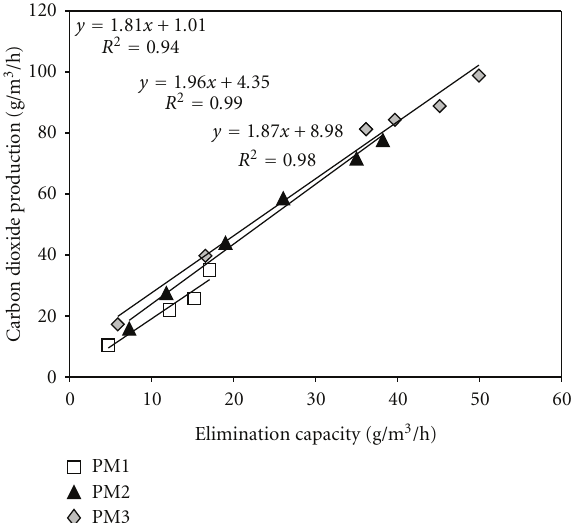
Figure 3: CO 2 production as a function of the EC of CH 4 in the biofilters packed with PM1, PM2, or PM3.